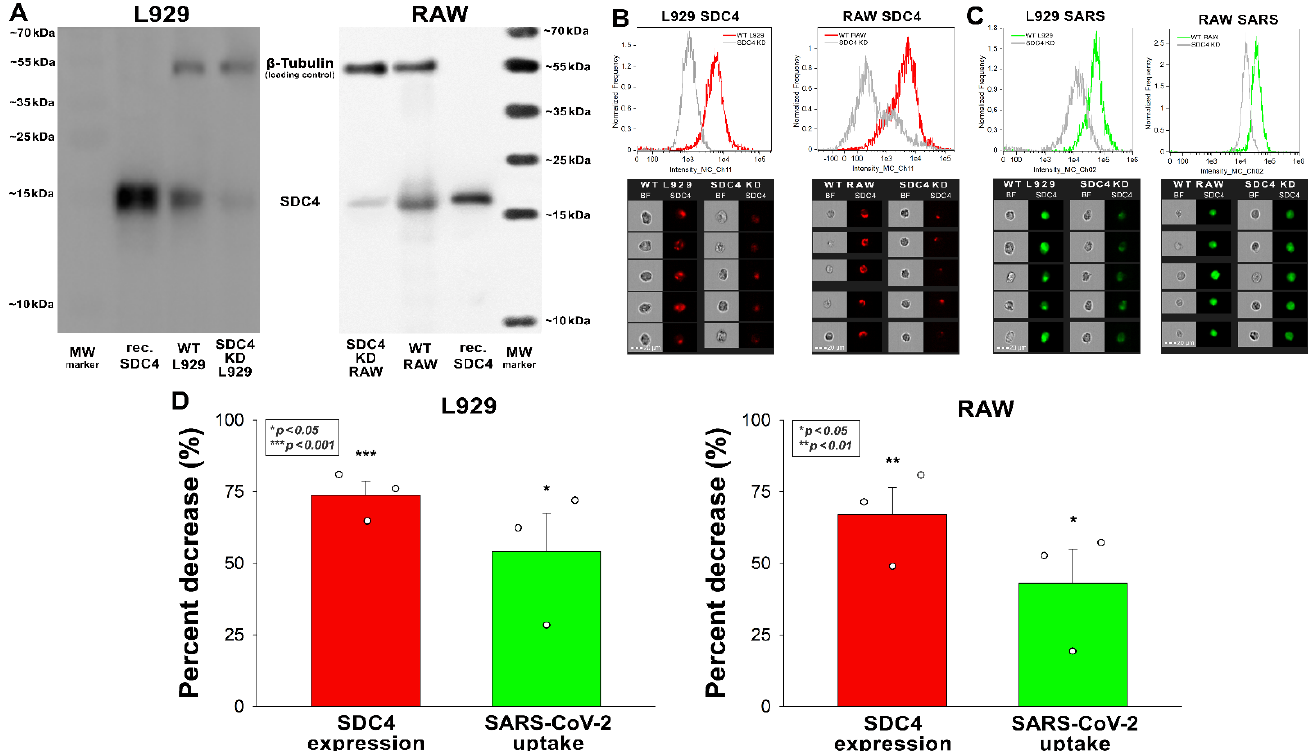
Figure 5. Effect of SDC4 knockdown (KD) on the internalization of inactivated SARS-CoV-2 into L929 and RAW cells. SDC4 KD in L929 and RAW cells was performed using a lentiviral vector specific to mouse SDC4. ( A ) Western blot validation of SDC4 kD in L929 and RAW cells. β -tubulin was used as a loading control. ( B ) SDC4 expression levels were also measured with imaging flow cytometry, as shown by the representative histograms and cellular images. Scale bar = 20 μm. Detected SDC4 levels of KD cells were normalized to WT cells as standards. ( C , D ) WT and SDC4 KD cells were incubated with inactivated SARS-CoV-2 (1 MOI) for 3 h at 37 °C. After incubation, the cells were washed, trypsinized, fixed, permeabilized, and treated with antibodies specific for the spike glycoprotein (and AF 488-labeled secondary antibodies). Cellular uptake of SARS-CoV-2 and spike was then analyzed with imaging flow cytometry. ( C ) Representative flow cytometry histograms and cellular images show the intracellular fluorescence of SARS-CoV-2-treated WT or SDC4 KD cells. Scale bar = 20 μm. ( D ) The effect of SDC4 KD on SDC4 expression and SARS-CoV-2 uptake ex- pressed as percent decrease. The bars represent the mean + SEM of three independent experiments. Statistical significance vs. controls was assessed with ANOVA. * p < 0.05; ** p < 0.01; *** p < 0.001. 2.4. Confocal Microscopic Assessment of SARS-CoV- 2′ s Internalization in Murine Cell Lines Next, we explored the colocalization of SARS-CoV-2 with SDC4 during uptake into L929 and RAW cells (Figure 6A,B). Taken at 3 h of incubation with inactivated SARS-CoV- 2, confocal microscopic studies revealed a high degree of overlap (expressed with the